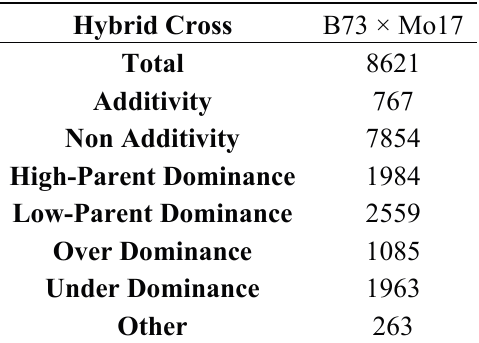
Table 2. Statistical analysis of differentially expressed genes (FDR ≤ 0.001 and absolute value of log Ratio ≥ 1). 2